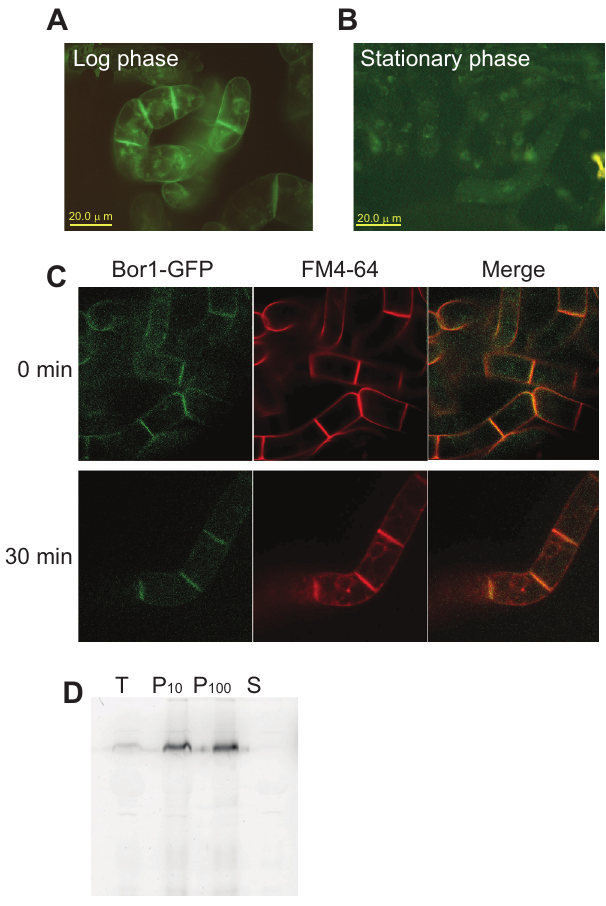
Figure 1. Expression of BOR1-GFP fusion protein in tobacco BY-2 cells. A . Fluorescence pattern of rapidly growing tobacco cells expressing BOR1-GFP was detected using an epifluorescence microscope. Plasma membranes as well as some intracellular structures showed GFP fluorescence. B . GFP fluorescence of tobacco cells expressing BOR1-GFP at stationary phase of growth. Images were collected as in A. C . Colocalization of plasma membrane and endomembrane marker FM4-64 and BOR1-GFP. Cells expressing BOPR1-GFP were suspended in medium containing FM4-64 and incubated for 15 min on ice. Fluorescence images were collected immediately after the incubation or 30 min after incubation at room temperature using a spinning disk confocal microscope. D . Membrane-association of BOR1-GFP. Cell lysate was subjected to two rounds of centrifugation and soluble and sedimentable fractions containing membranes was obtained. T, total cell lysate. P10, pellet of 10,000 x g 10 min centrifugation. P100, pellet of 100,000 x g 60 min centrifugation. S, soluble fraction after 100,000 x g 60 min